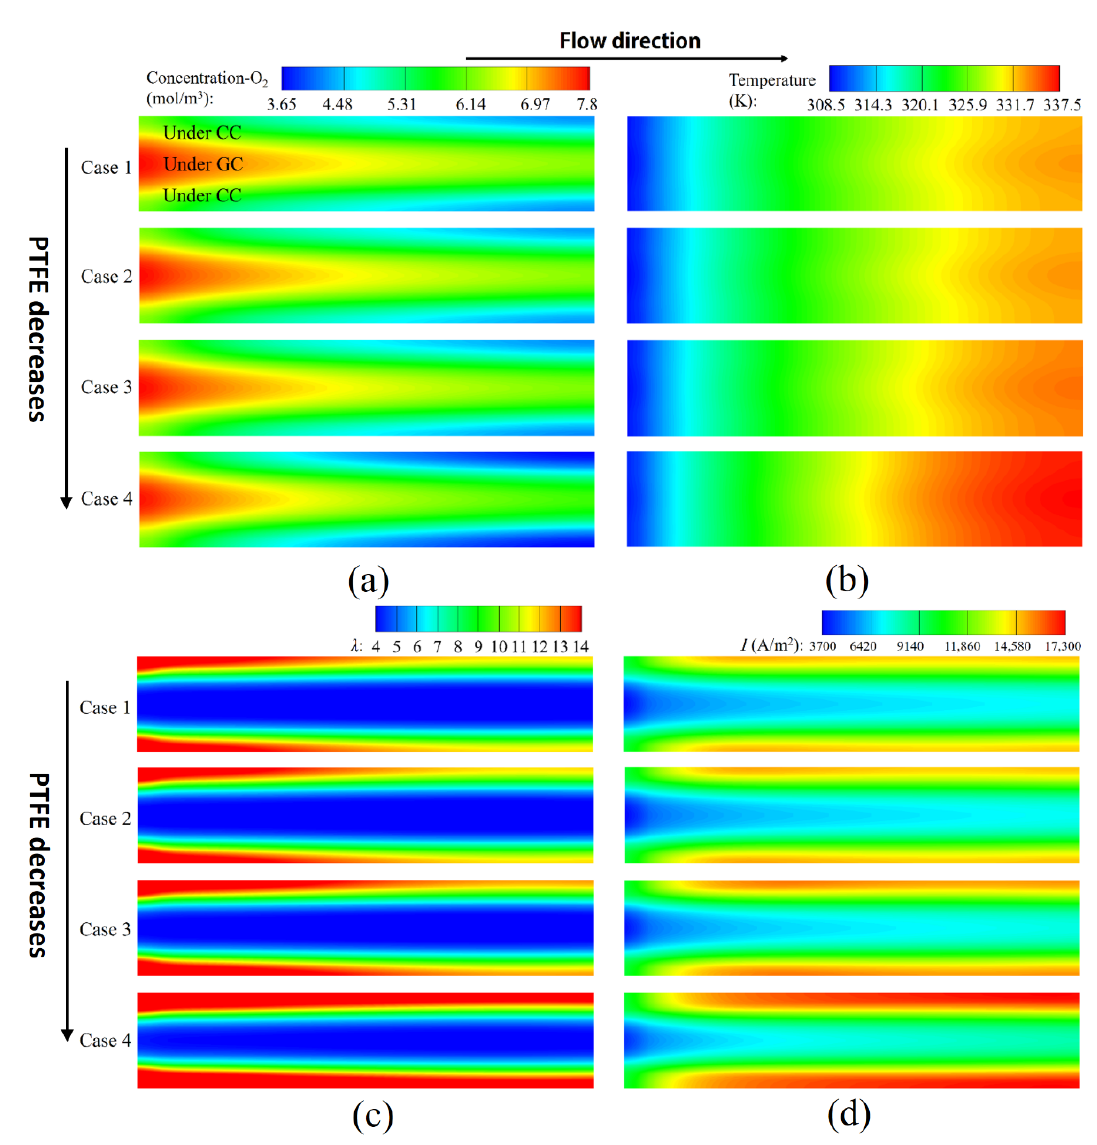
Figure 5. Comparison of key variable distribution in Cases 1–4 with GDL of different PTFE content: ( a ) oxygen concentration ( b ) temperature, ( c ) dissolved water content and ( d ) current density distribution in the middle plane of CCL.